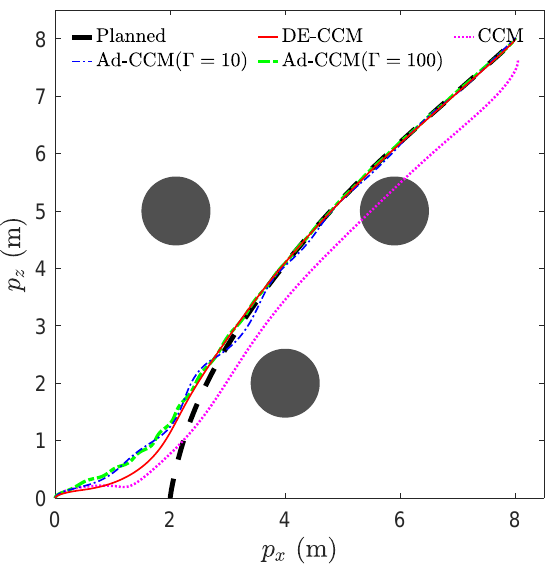
Figure 5. Trajectory tracking performance of different